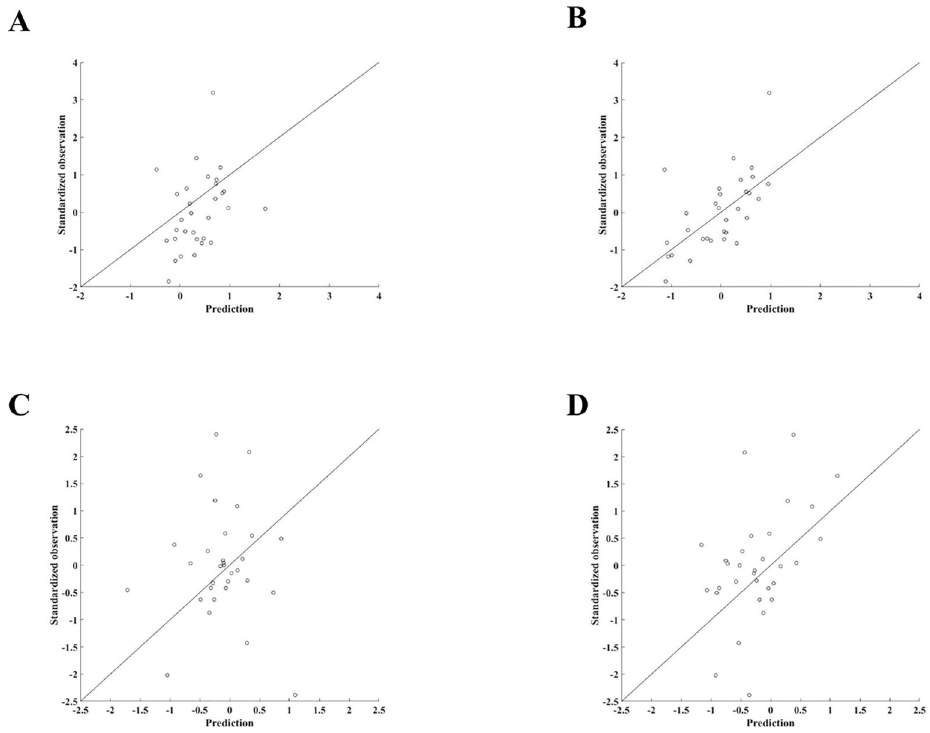
Fig 4. ARDBN and DDDBN model predictions. (A, C) Generated model predictions for the spring and fall zooplankton by the ARDBN and (B, D) DDDBN model respectively. Note the negative scale is due to standardization.